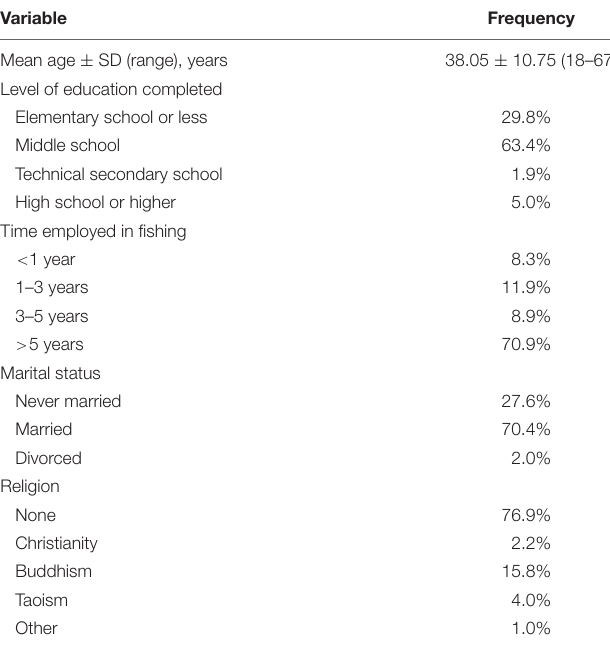
TABLE 1 | Demographic characteristics of the present study cohort of